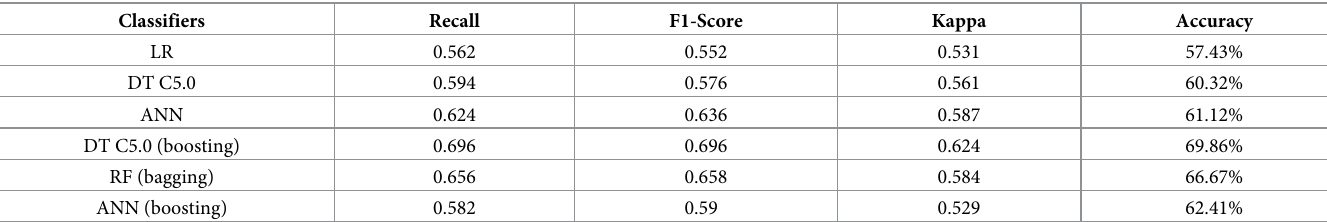
Table 10. Performance comparison of quinary classification models with different classifiers.